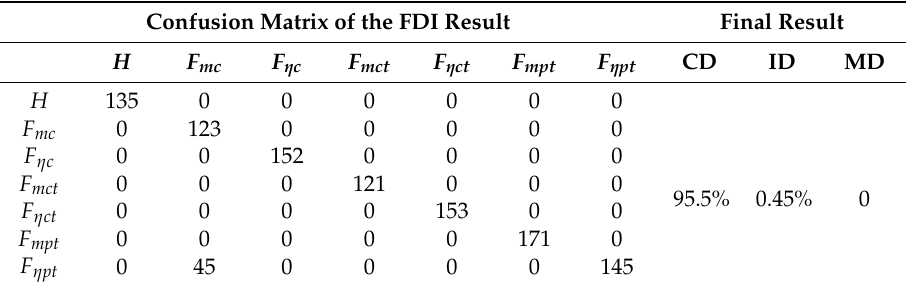
Table 5. The fault detection and isolation (FDI) results of the 1000 stochastic